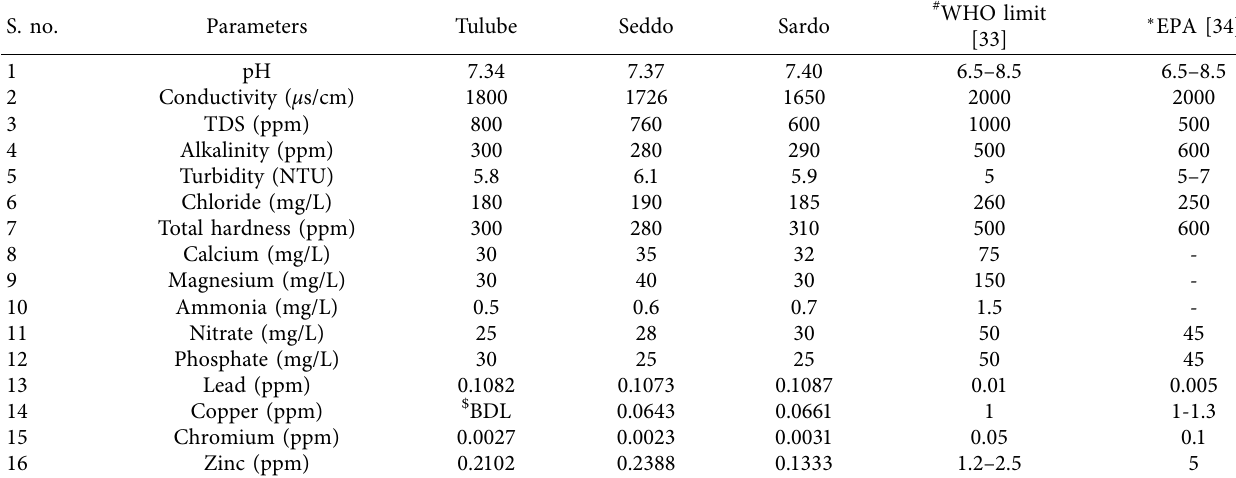
Table 1: Laboratory results for physiochemical water quality parameters of water